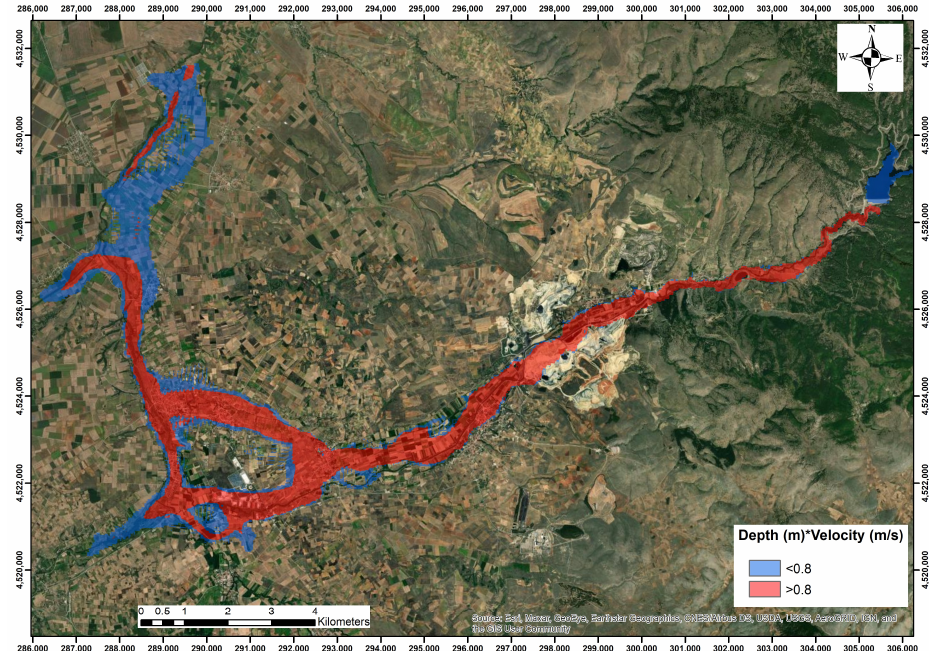
Figure 19. Flood hazard maps for the overtopping dam failure scenario (second classification ap- proach).